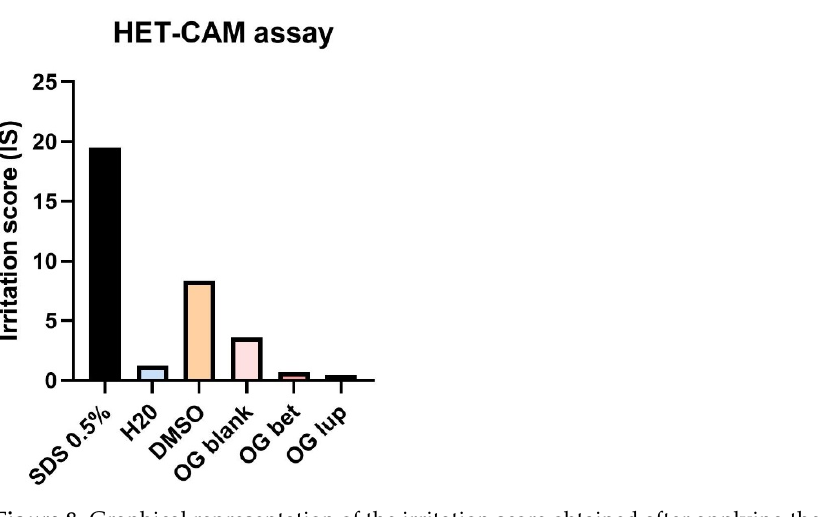
Figure 8. Graphical representation of the irritation score obtained after applying the samples on the chorioallantoic membrane. The positive control is represented by SDS, and the negative control is represented by distilled water. Table 5. Irritation score (IS) for SDS, DMSO, H 2 O, Blank OG, Bet OG, and Lup OG 500 µg/mL and the occurrence time of hemorrhage ( t H ), lysis ( t L ), and coagulation ( t C